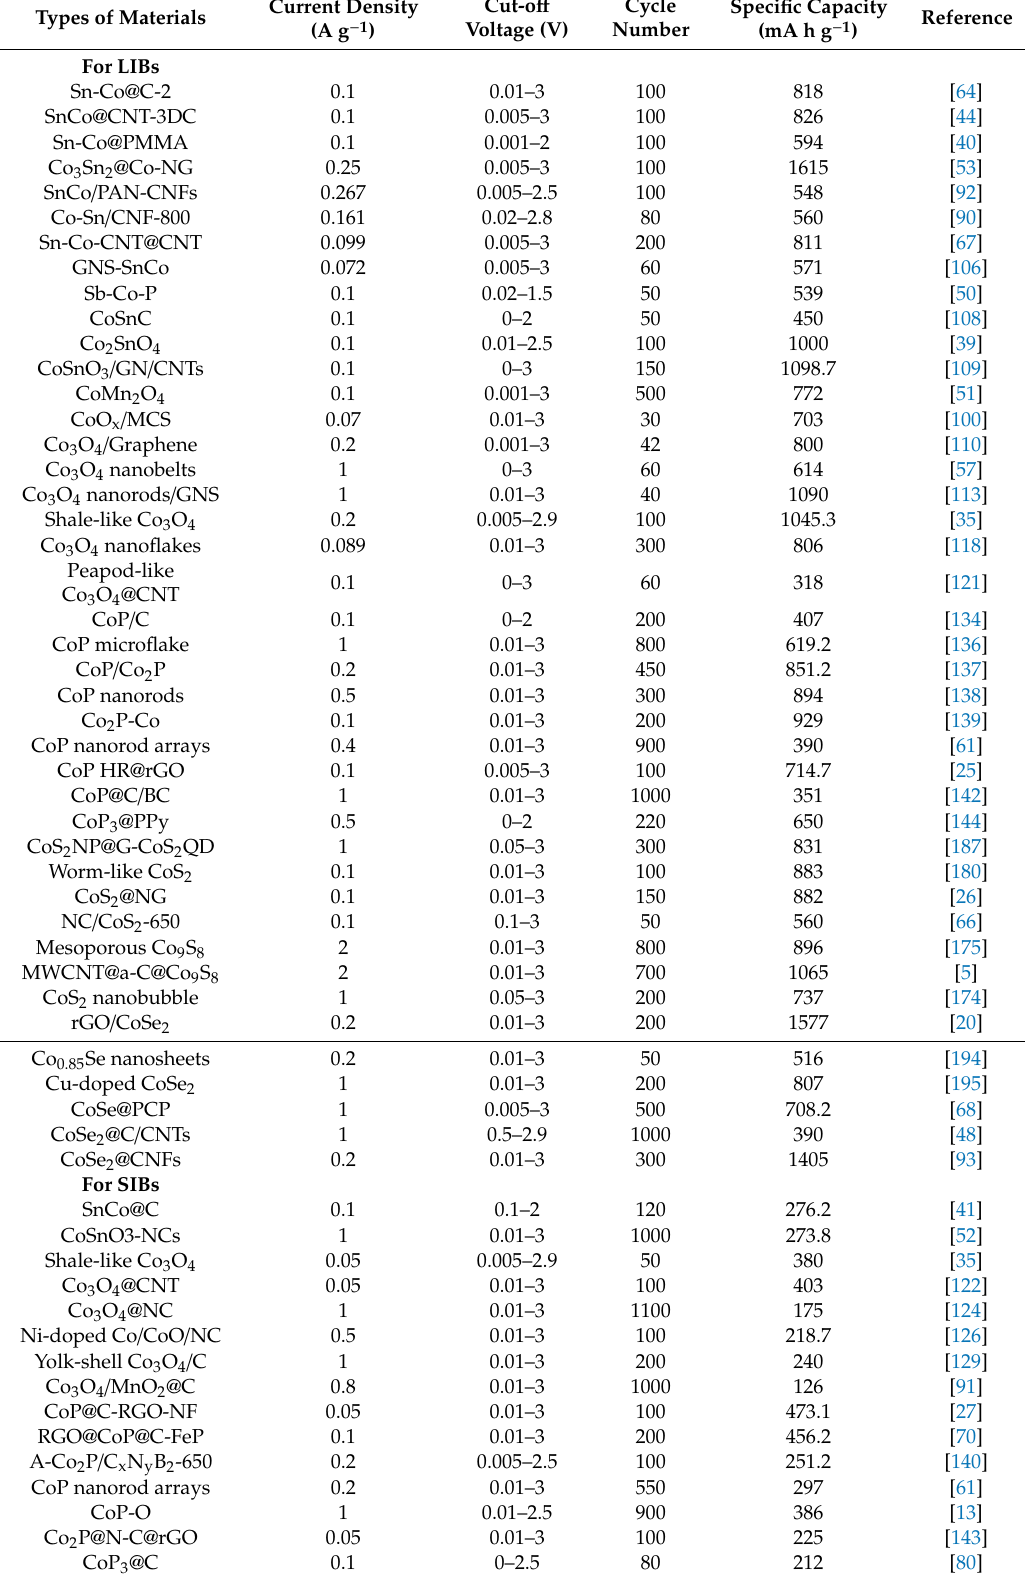
Table 3. Summary of the Li / Na-storage performances of typical cobalt-based anode materials. LIBs: lithium ion batteries and SIBs: sodium ion